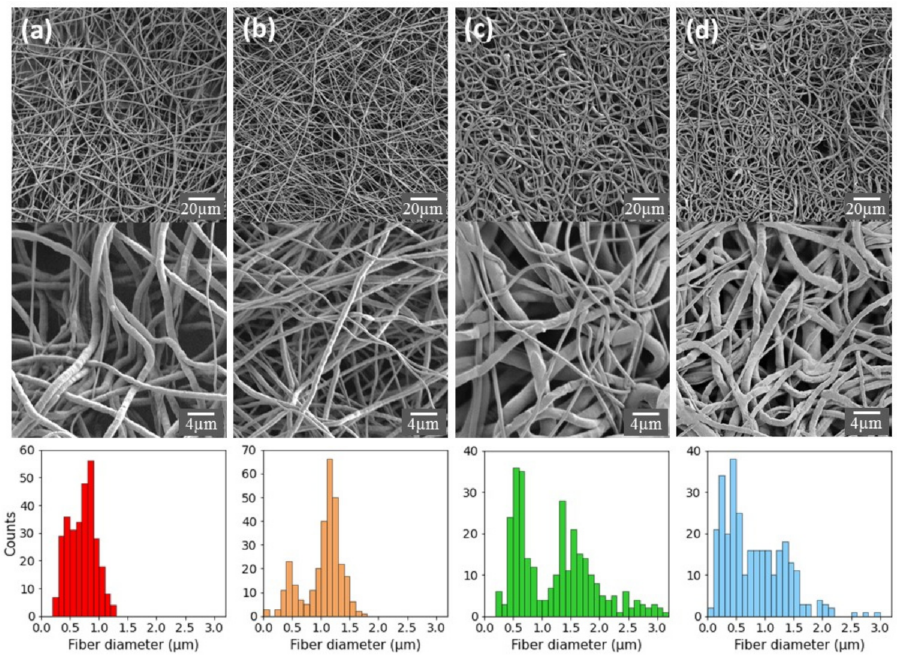
Figure 2. SEM micrographs (top), zoom in on the fibers (middle), and fiber diameter distribution (bottom) for electrospun meshes of ( a ) polycaprolactone (PCL), ( b ) PCL + Fmoc-phenylalanine- arginine-glycine-aspartic acid (FmocFRGD), ( c ) hyaluronic acid (HA)/PCL core/shell, and ( d ) HA + FmocFRGD/PCL core/shell